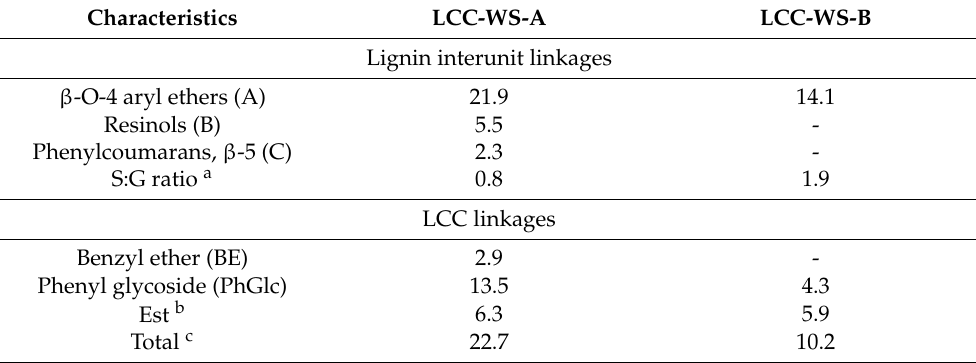
Table 2. Amounts (semi-quantitative data) of lignin substructures and lignin-carbohydrate linkages in LCC-WS-A and LCC-WS-B (per 100